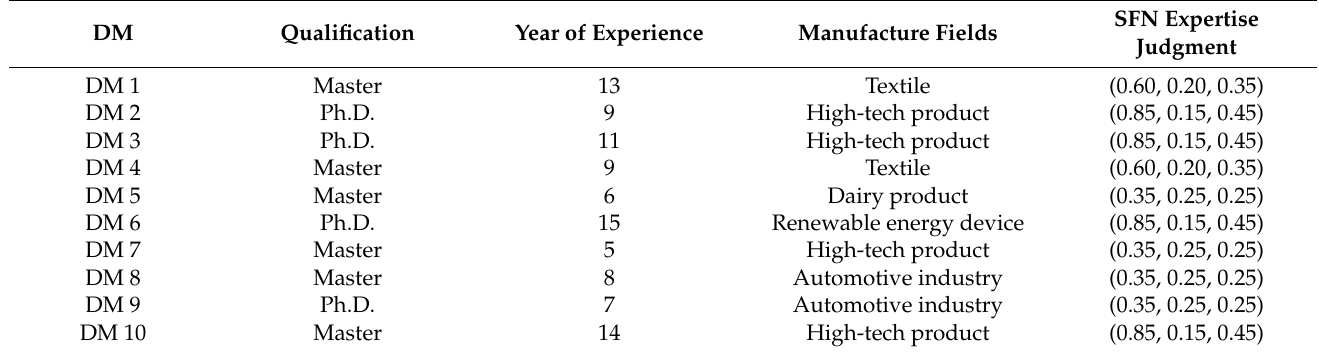
Table A1. Decision-makers’ qualifications, experience, and manufacture field.